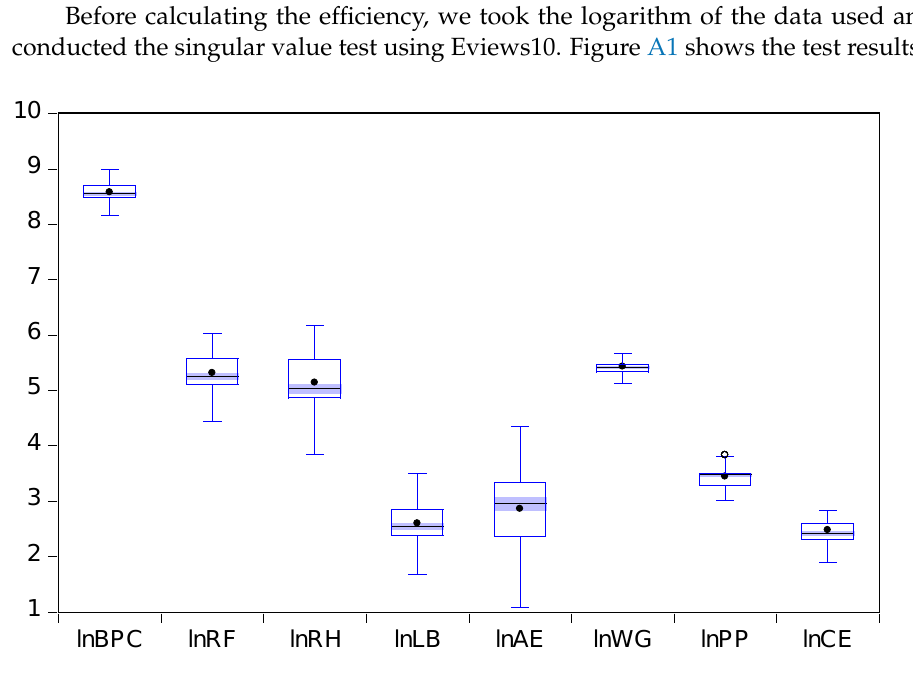
Figure A1. Outlier Test Results of the Data Using the DEA Models. Except for the PP values of several samples that fell close to the boundary, all the data were located within the range of the upper inner fence and the lower inner fence. After examining the questionnaires, all samples were confirmed to be correct and credible.